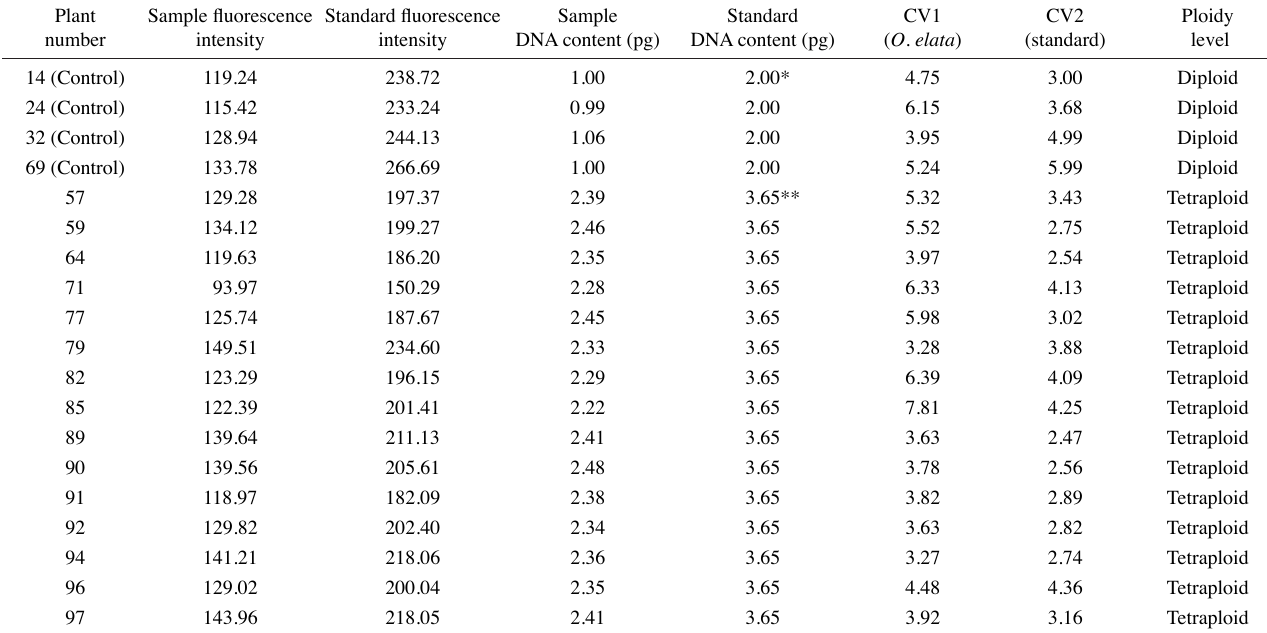
Tab. 2: Fluorescence intensity, average DNA content, and CV values in samples with and without colchicine treatment Plant